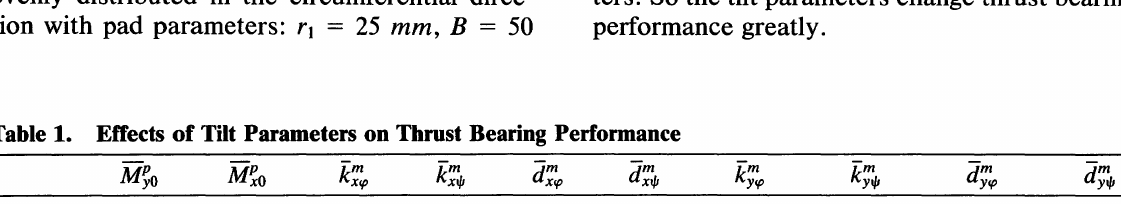
Table 1. Effects of Tilt Parameters on Thrust Bearing